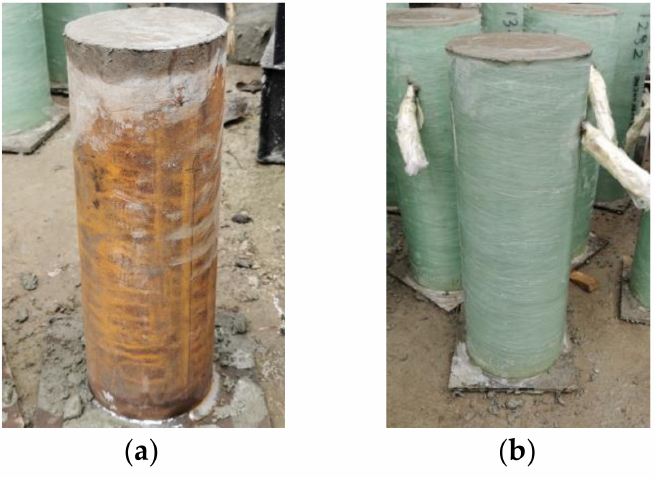
Figure 6. The confined RAC specimens. ( a ) RCFST; ( b )